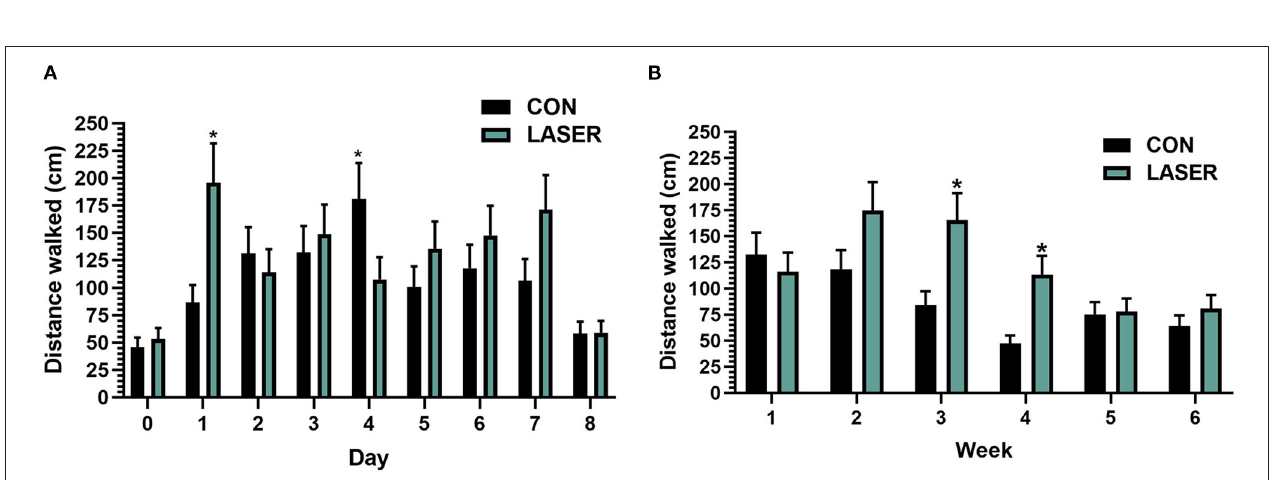
FIGURE 3 | (A,B) Mean walking distance a (cm) of focal birds during 4-min laser periods over: (A) d0–8 (enrichment × day LSMeans ± SEM); and (B) wk 1–6 (enrichment × week LSMeans ± SEM) b . Following the first d0–8, Thursdays of each week were selected for behavior video recording. a Total distance convergence criteria relaxed to 10 − 6 . b Bars denoted * indicate means that are significantly different within the same day/week ( P ≤ 0.05).